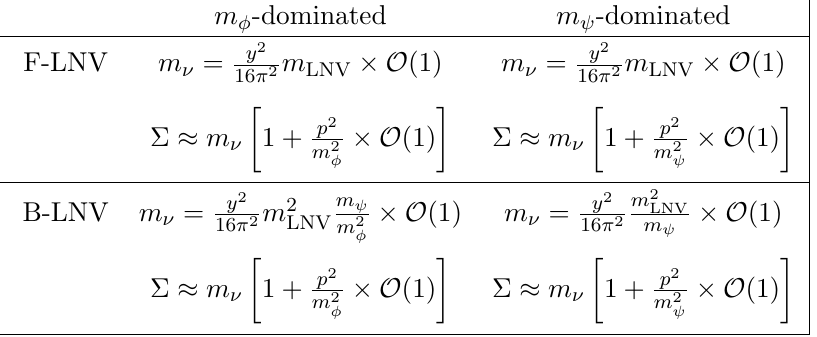
Table 1 . Neutrino masses ( m (cid:23) ) and self-energies ((cid:6)) obtained from computing the 1-loop F-LNV and B-LNV diagrams in (cid:12)gure